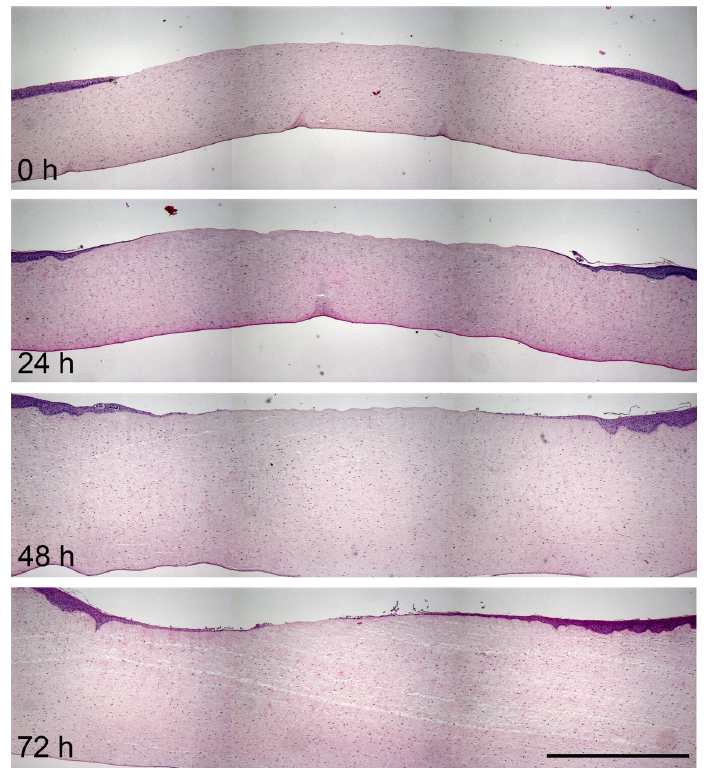
Figure 3. Histological documentation of the corneal wound healing process in HE-stained paraffin sections. HE-stained paraffin sections of the cornea were analysed with a stereomicroscope to follow wound healing of a 4 mm defect at day 1, 2 and 3. Thickening of the corneal stroma due to swelling processes is evident. Several single images were taken in a good magnification and via mosaic tool combined to a cornea overview. Scale bar represents 1 mm.